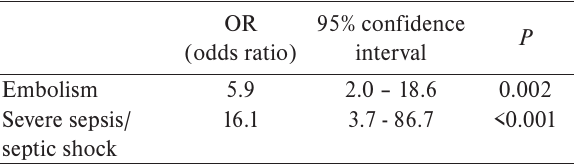
Table 4. Logistic regression for in-hospital mortality, simulta- neous embolism and severe sepsis/septic shock.